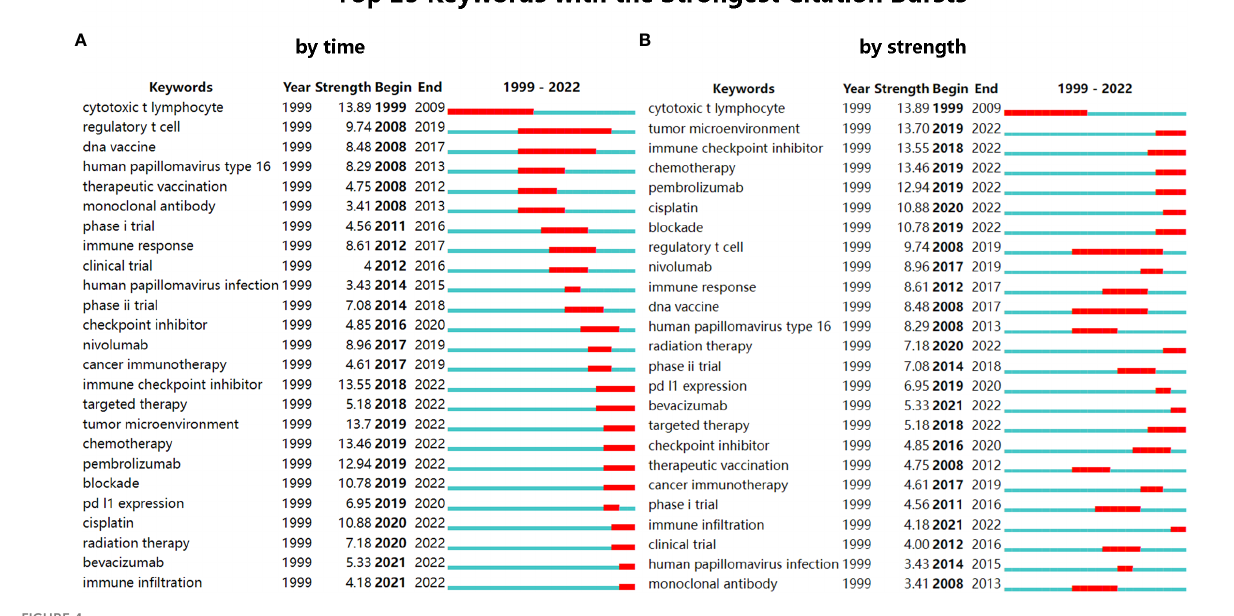
FIGURE 4 (A) The top 25 keywords with the strongest citation bursts, sorted by time. (B) The top 25 keywords with the strongest citation bursts, sorted by